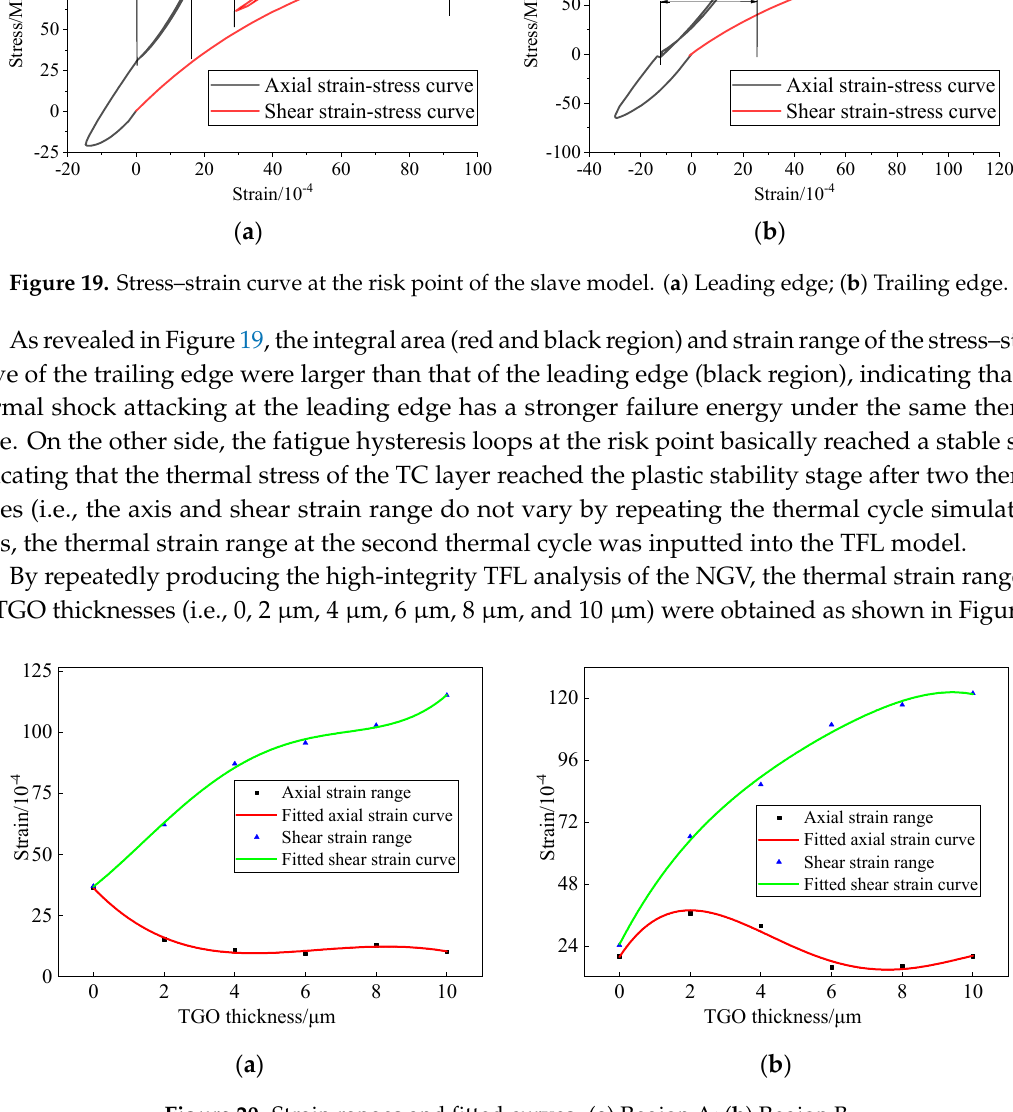
Figure 20. Strain ranges and fitted curves. ( a ) Region A; ( b ) Region B.